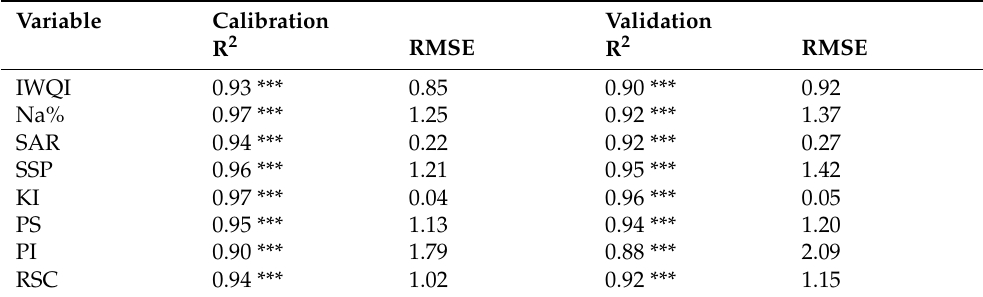
Table 6. Outcomes of the calibration and validation models of the SVMR of the association between the observed and predicted IWQI, Na%, SAR, SSP, KI, PS, PI, and RSC of the groundwater quality. Variable Calibration Validation R 2 RMSE R 2 RMSE IWQI 0.93 *** 0.85 0.90 *** 0.92 Na% 0.97 *** 1.25 0.92 *** 1.37 SAR 0.94 *** 0.22 0.92 *** 0.27 SSP 0.96 *** 1.21 0.95 *** 1.42 KI 0.97 *** 0.04 0.96 *** 0.05 PS 0.95 *** 1.13 0.94 *** 1.20 PI 0.90 *** 1.79 0.88 *** 2.09 RSC 0.94 *** 1.02 0.92 ***